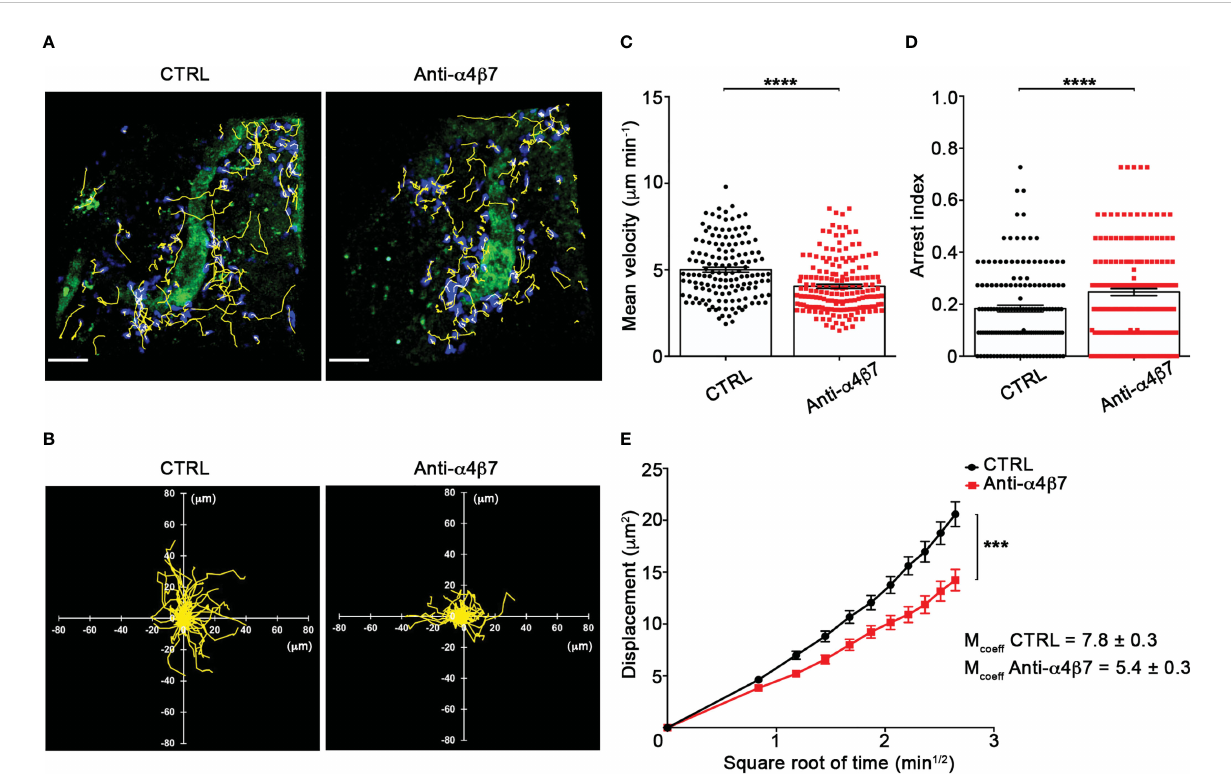
FIGURE 7 a 4 b 7 integrin selectively controls Th17 cells dynamics in the spinal SAS at disease peak. Cell preparation and TPLSM imaging were perform as described for Figure 5. (A) Representative images of Th17 cells before (CTRL) and after 30 min of anti- a 4 b 7 integrin treatment (anti- a 4 b 7 antibody) (scale bar = 50 m m). (B) Normalized trajectories of 70 Th17 cells over 12 time points before and after anti- a 4 b 7 antibody. (C) mean velocity and (D) arrest index of Th17 cells before and after integrin blockade. Statistical signi fi cance was calculated using the Mann – Whitney test (**** P < 0.0001). (E) Mean displacement of Th17 cells is strongly decreased by anti- a 4 b 7 blocking antibodies (After linear regression application, the differences between slopes resulted extremely signi fi cant; *** P < 0.0001). Data are expressed as mean ± SEM. A total of 146 cells were analyzed for CTRL and 176 after anti- a 4 treatment from three independent experiments. Track lower than 12 time points were excluded from the